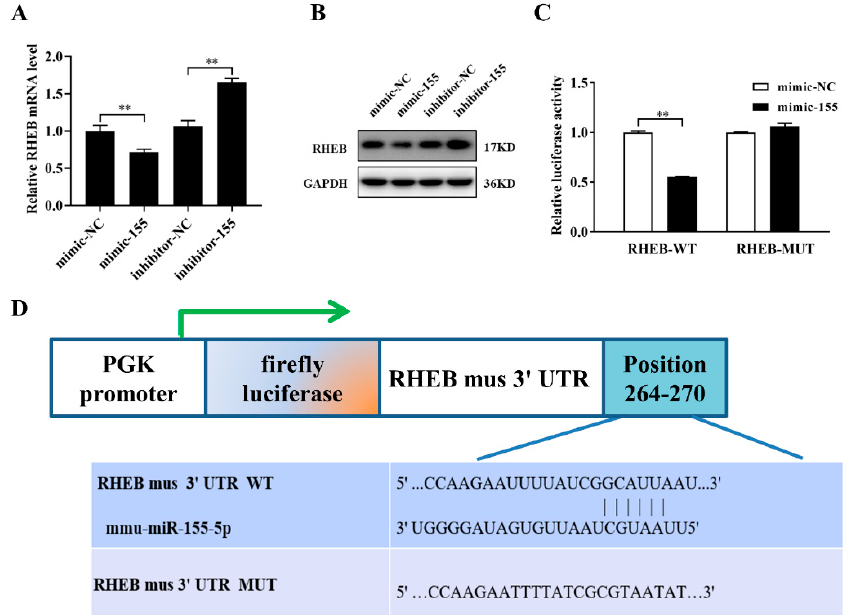
Figure 5. MiR-155-5p directly downregulates RHEB in microvascular endothelial cells. ( A ) qRT-PCR analysis of RHEB mRNA expression in microvascular endothelial cells treated with mimic-155-5p, inhibitor-155-5p or the corresponding controls for 48 h (N = 3). ( B ) Western blotting analysis of the protein expression of RHEB (N = 3). ( C ) After 293T cells were treated with mimic-155-5p and the corresponding controls for 48 h, the luciferase activities of the RHEB WT and MUT reporters were evaluated. (N = 3). ( D ) Schematic representation of the luciferase reporters containing RHEB 3 ′ -UTR WT or MUT sequences. * p < 0.05, ** p < 0.01 vs. control.